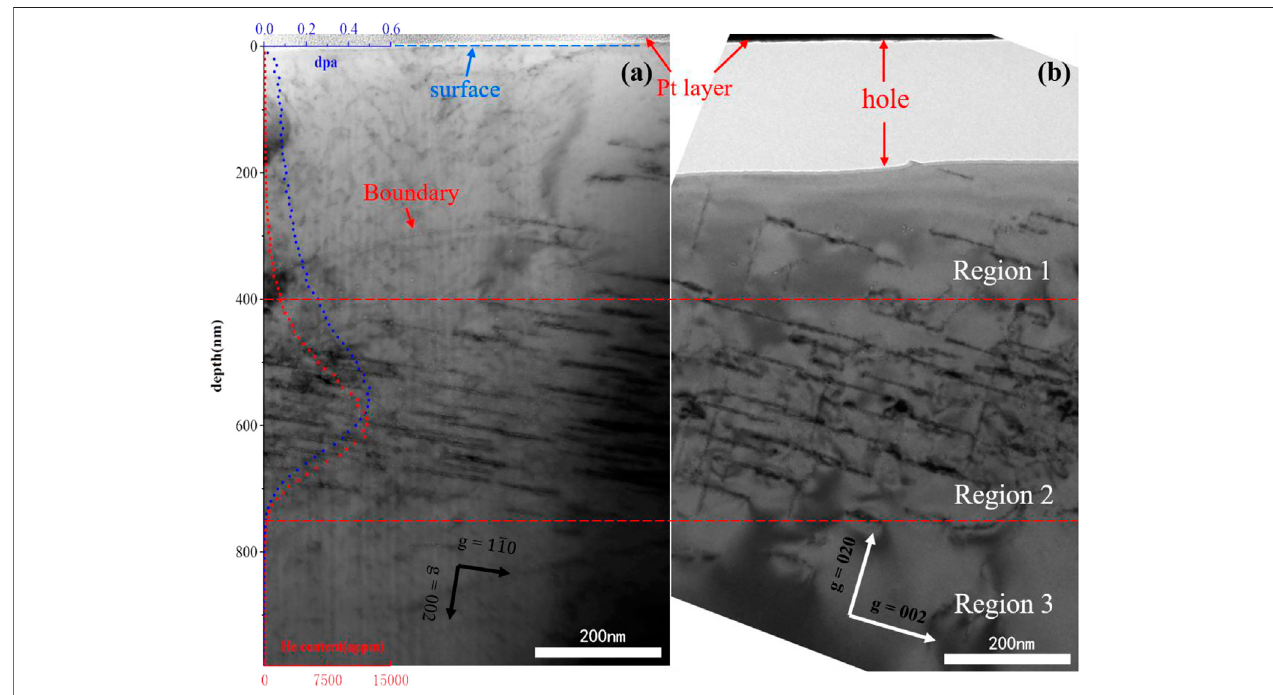
FIGURE 2 | TEM bright- fi eld (BF) images showing the spatial distribution of bubbles of Fe-9Cr alloy (A) under < 110 > zone axis and (B) under < 100 > zone axis.